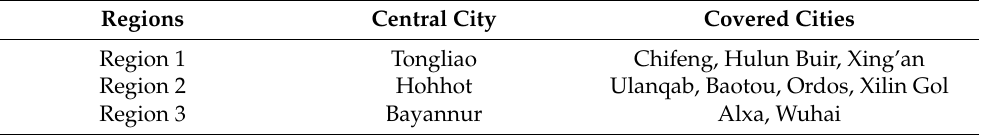
Table 6. The final location results for the 2SM. Regions Central City Covered Cities Region 1